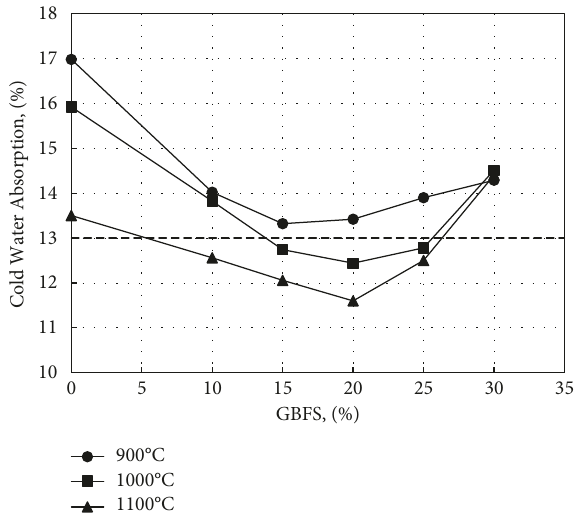
Figure 7: Effect of GBFS addition on cold water absorption. (Dotted line corresponds to maximum value following ASTM